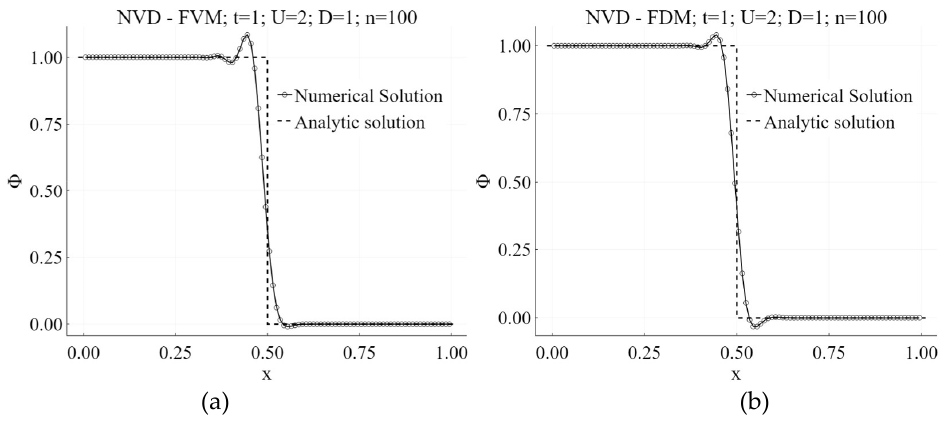
Figure 4. Examples of well-behaving advection schemes. ( a ): Higher order upwind biased FVM scheme with mild numerical diffusion and mild oscillations; ( b ): Higher order upwind biased FDM scheme with mild numerical diffusion and very mild oscillations.